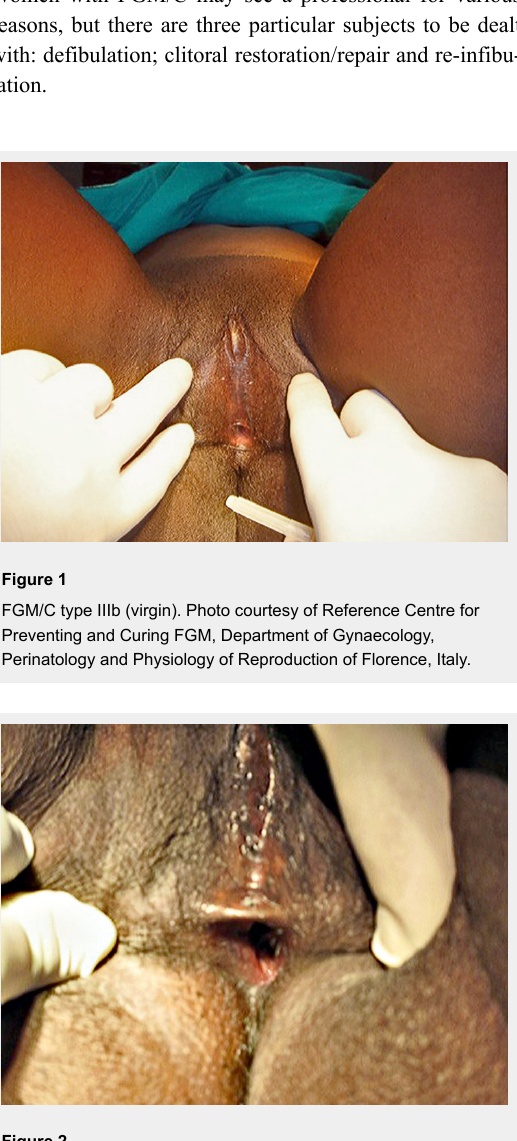
FGM/C type IIIb (sexually active). Photo courtesy of Reference Centre for Preventing and Curing FGM, Department of Gynaecology, Perinatology and Physiology of Reproduction of Florence,